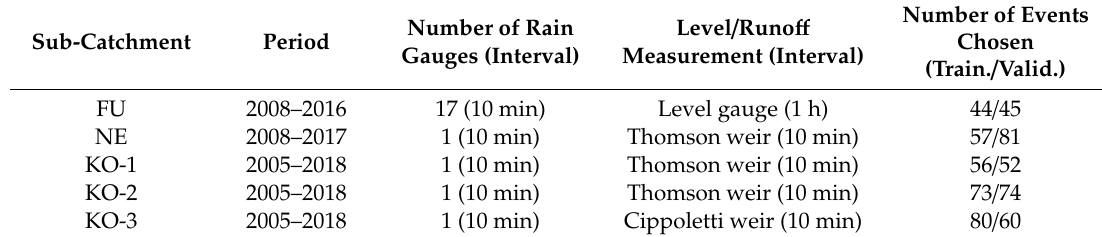
Table 2. Overview of rainfall and level / runo ff measurements in the study catchments; Number of events chosen for training and validating